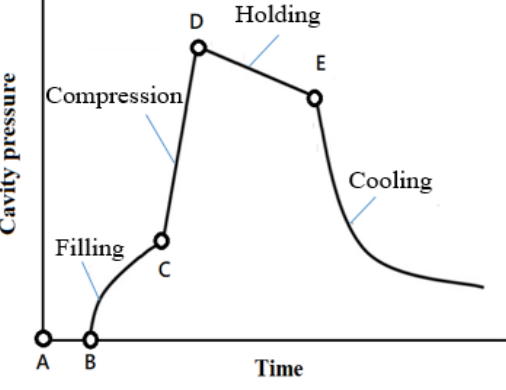
Figure 1. Typical cavity pressure profile.